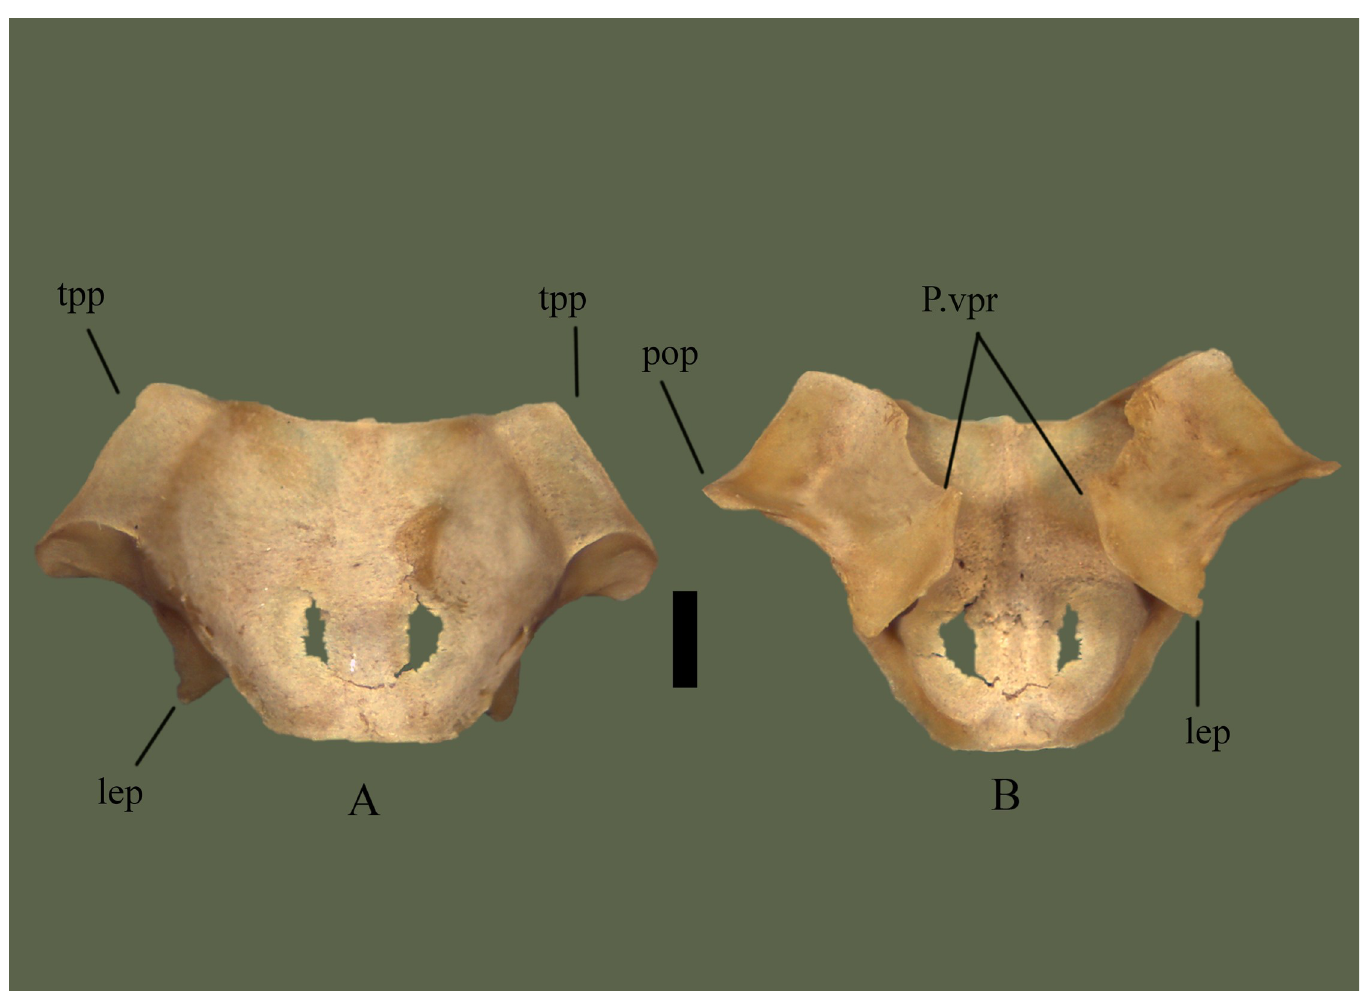
Fig 13. Parietal (ETVP 3306) in dorsal (A) and ventral (B). Anterior is to the top. Scale bar = 1mm. Abbreviations: p.vpr = parietal ventral process; pop = postorbital process of parietal; lep = lateral extension of parietal; tpp = transverse process of